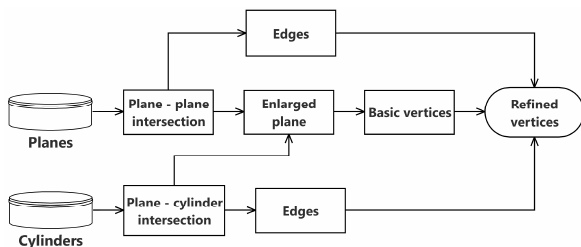
Figure 2: Flowchart of the proposed methodology to calculate the vertices of the walls.